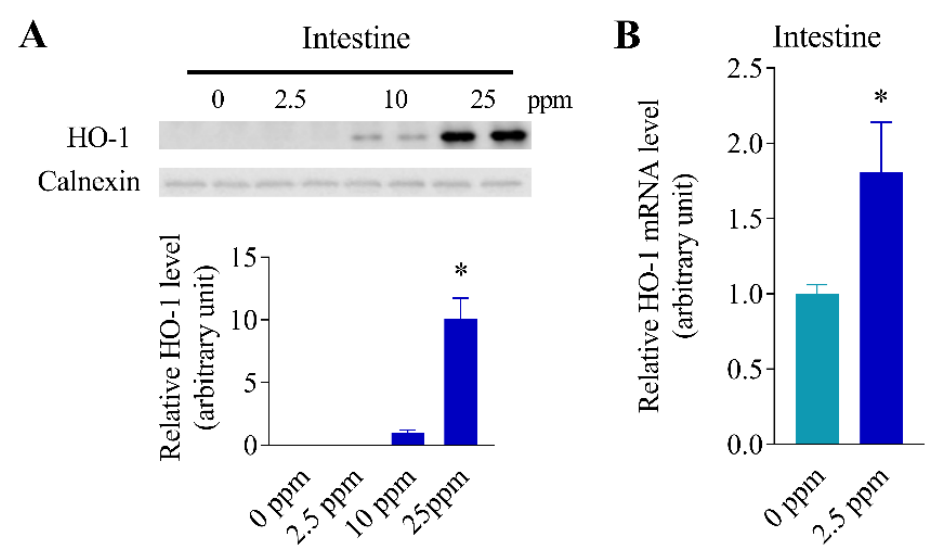
Figure 5. Inducibility of intestinal HO-1 expression at lower arsenic doses. Relative HO-1 protein and mRNA levels were determined for small intestinal epithelial cells of female, 3–4-month-old mice, after 7 days of arsenic exposure via drinking water at 2.5, 10, or 25 ppm. Mice given drinking water only (0 ppm) were used as controls. ( A ) Microsomal HO-1 protein levels were determined by immunoblot analysis. Microsomes were prepared from pooled small intestinal epithelial cells of 3–4 mice per group. Each lane contained 10 µ g of total microsomal protein. Samples were analyzed in duplicates. Densitometry data (means ± SD of duplicate determinations) were normalized by calnexin level in each sample and the average level in the 10-ppm sample was set to 1.0. *, p < 0.05, vs. 10 ppm (unpaired t-test, two-tailed). ( B ) HO-1 mRNA levels were determined by RT-PCR. Data represent means ± SD of individual mice analyzed ( n = 3), and were normalized to GAPDH levels; *, p < 0.05, vs. 0-ppm control (unpaired t-test, two-tailed).